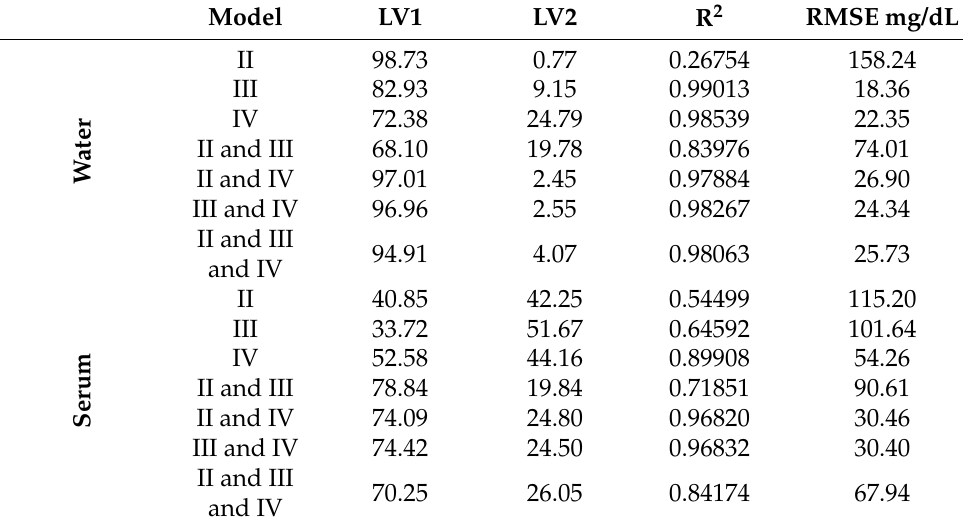
Table 2. PLS models’